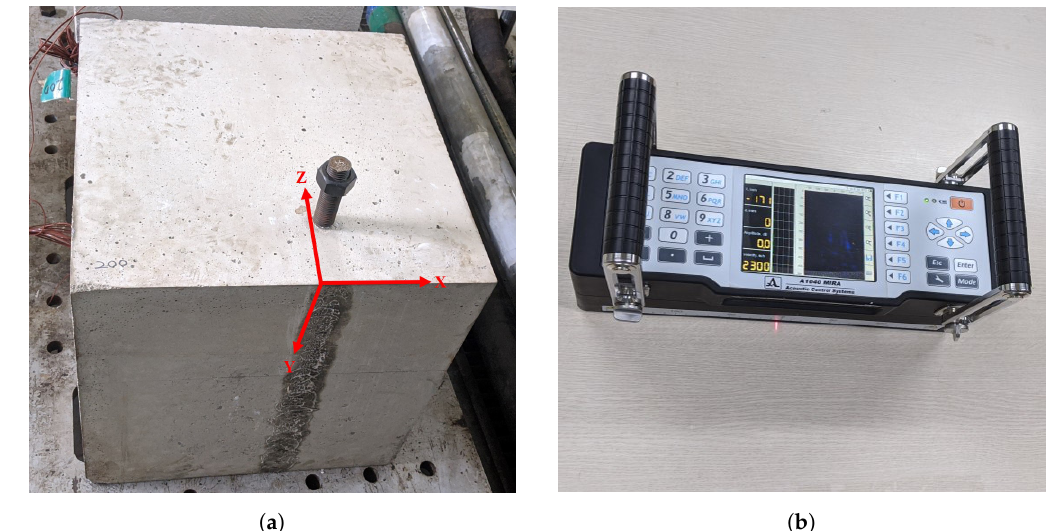
Figure 7. ( a ) Scanning target concrete cube specimen and ( b ) ultrasonic array device A1040